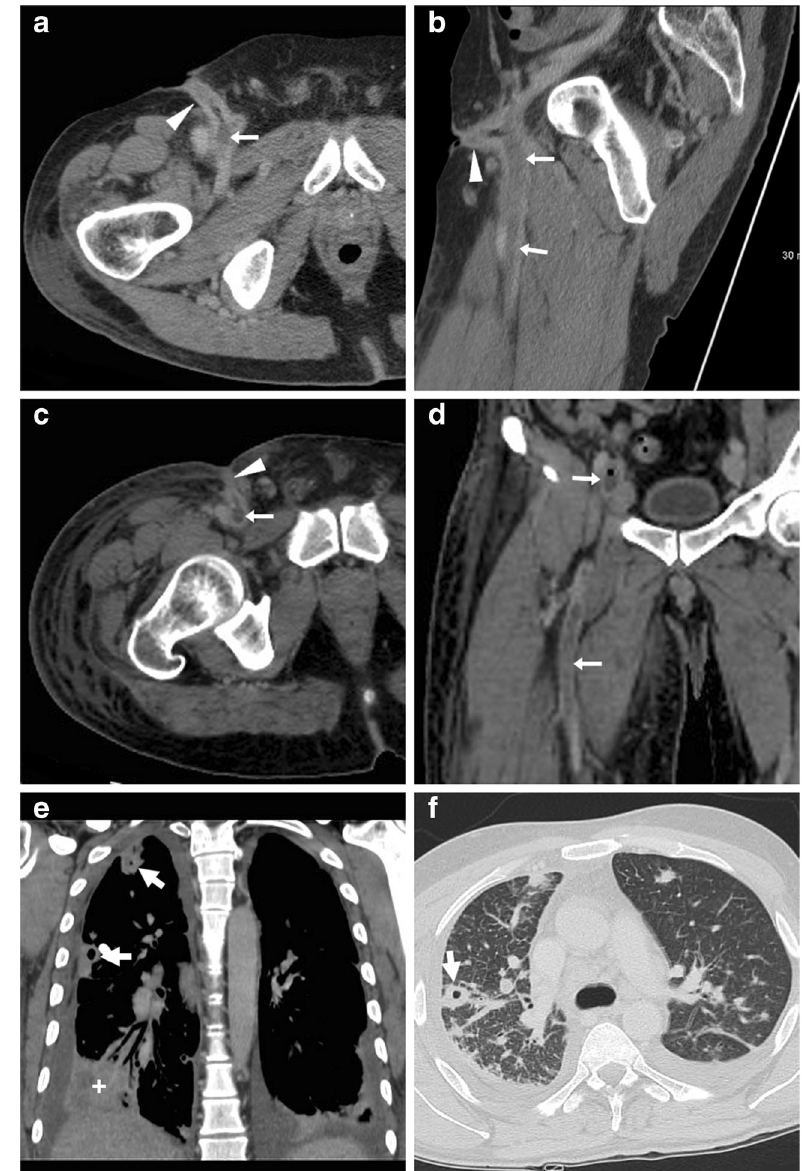
showed hypoattenuating collection (*) with peripheral enhancement, ex- tending ventrally fromthe CFA course. Antibiotics ultimately relieved the